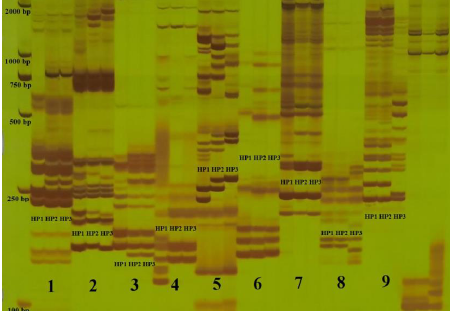
Figure 2. Genetic diversity of elite Honglian type of hybrid rice varieties.Markers (RM219, RM236, RM274, RM253, RM424) distinguished HP1 with HP2 and Hp3. Markers RM236 and RM424 dis- tinguished HP2 with HP1 and HP3. Markers RM424, RM481 and RM493 distinguished HP3 with HP1 and HP2.